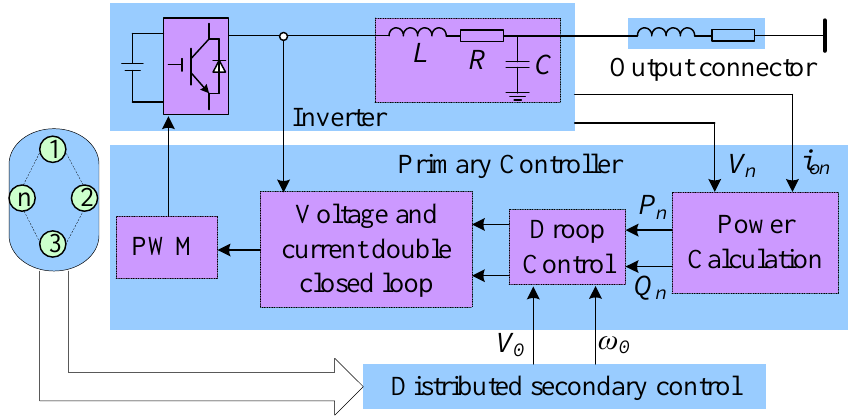
Figure 1. The control diagram of an islanded inverter-based DG. The conventional voltage and frequency droop characteristics for the i th DG in the primary control layer can be expressed as